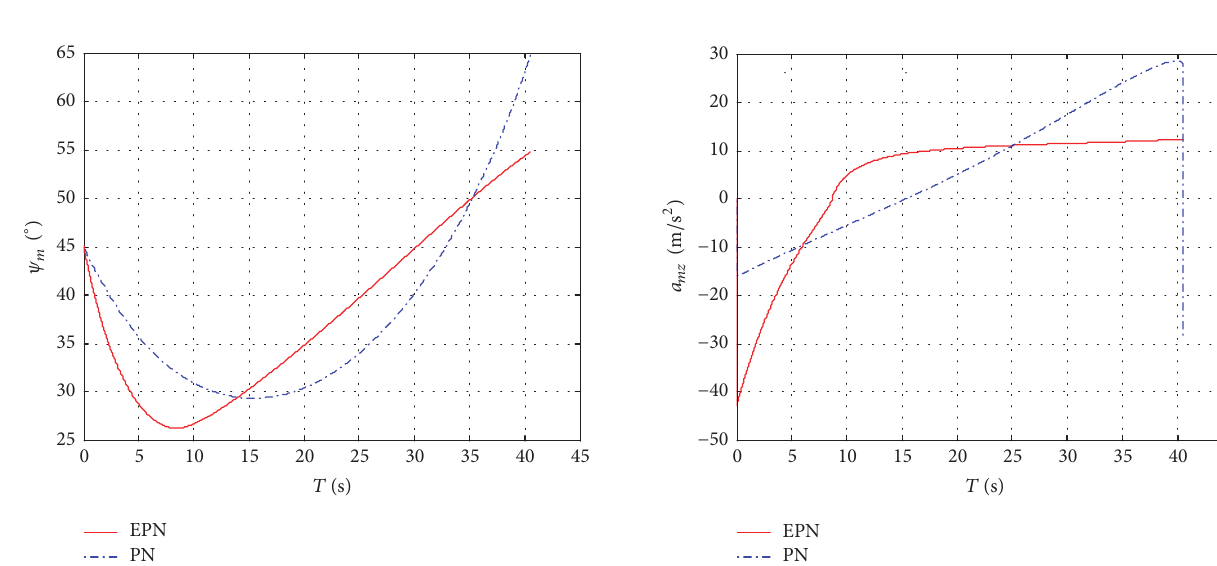
Figure 5: Time history of trajectory elevation.